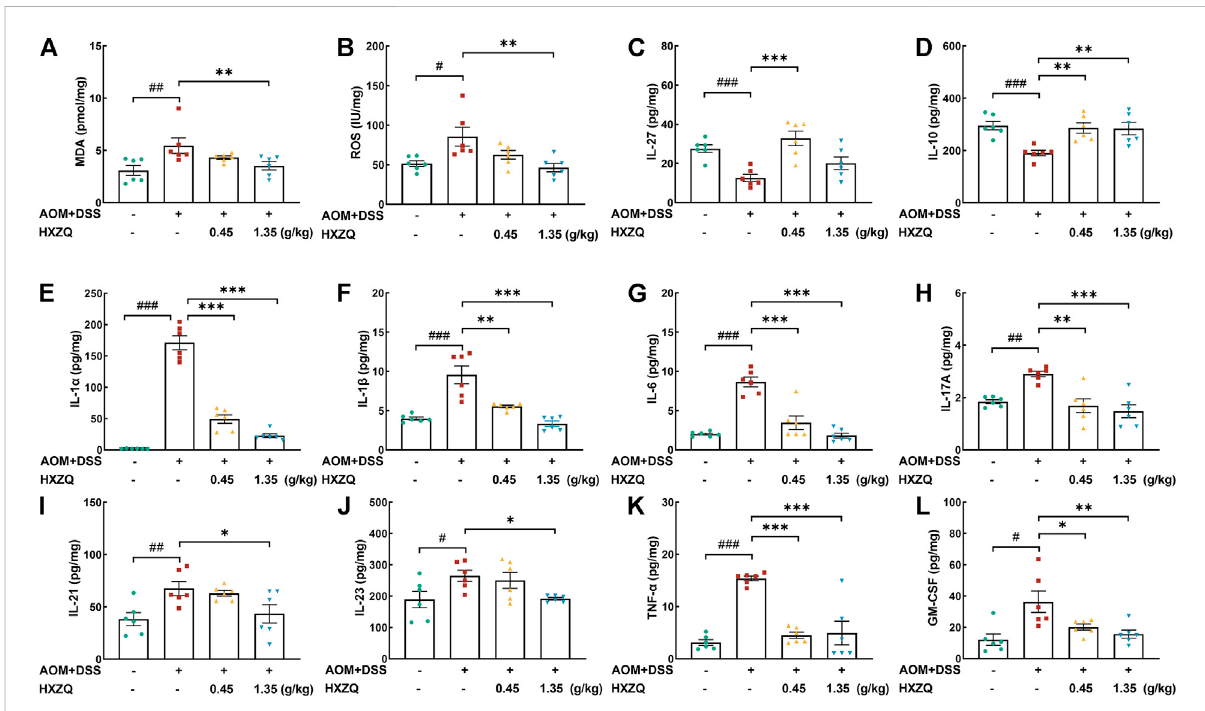
FIGURE 4 The effects of HXZQ on colorectum cytokines of AOM/DSS mice, including oxidative stress factors (A) MDA and (B) ROS, anti-in fl ammatory cytokines, (C) IL-27and (D) IL-10,andpro-in fl ammatoryfactors, (E) IL-1 α , (F) IL-1 β , (G) IL-6, (H) IL-17A, (I) IL-21, (J) IL-23, (K) TNF- α , (L) GM-CSF.Data are presented as themeans± S.E.M. and biochemical indices werecomparedbetweenCtrl and Model using Student ’ st-test. Comparisons between Model, 0.45 g/kg HXZQ, and 1.35 g/kg HXZQ were performed with one-way ANOVA followed by a post hoc multiple comparisons (Dunnett) test ( n = 6). # p < 0.05, ## p < 0.01, and ### p < 0.001 vs. Ctrl group; * p < 0.05, ** p < 0.01, and *** p < 0.001 vs. model